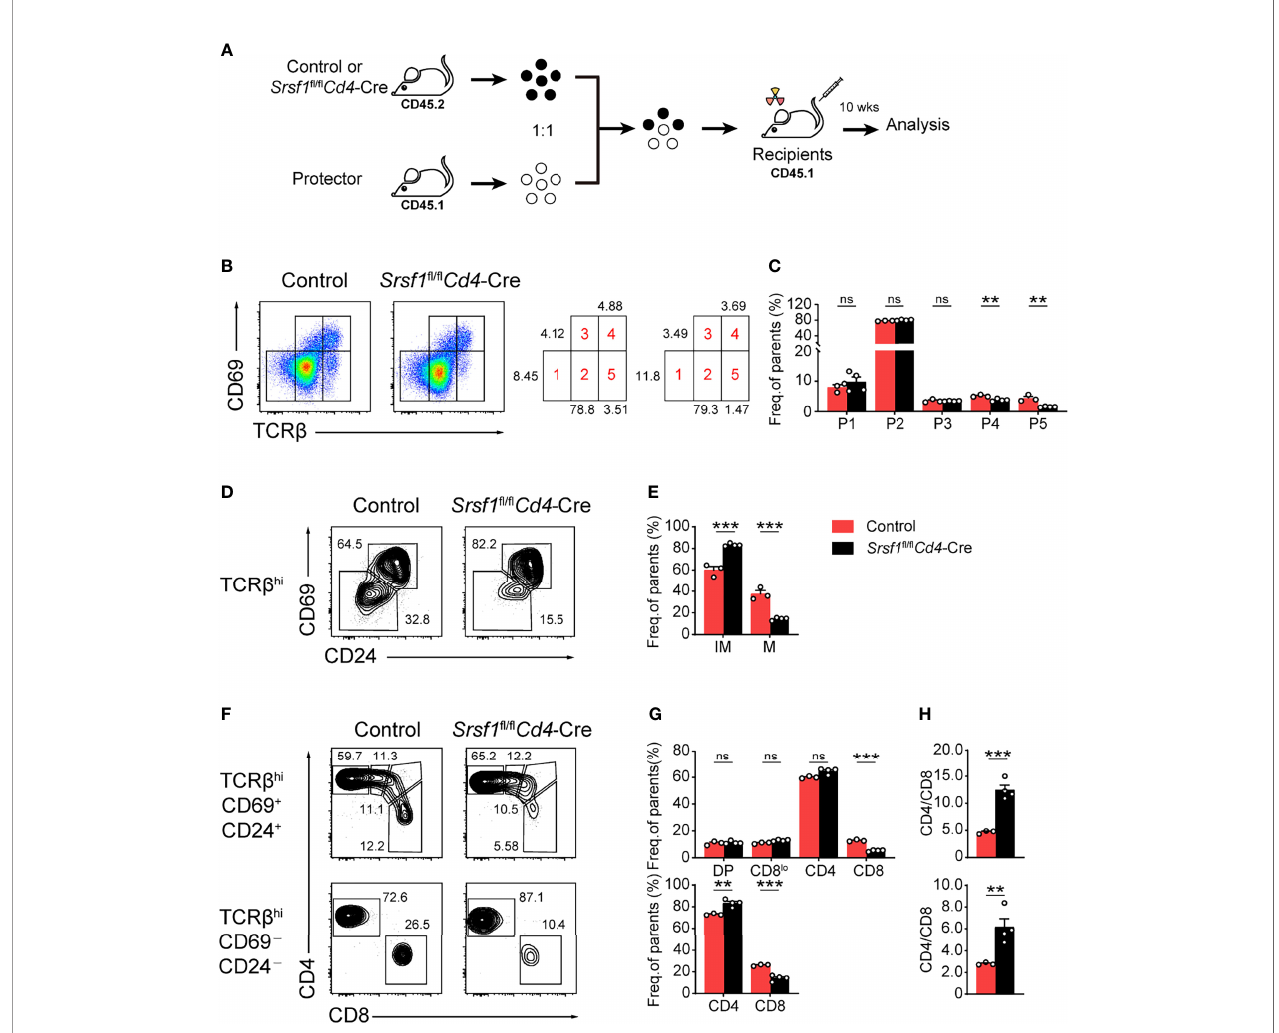
FIGURE 4 | SRSF1 intrinsically regulates the maturation of late thymocytes. (A) The scheme of bone marrow chimeric mice generation. A 1:1 mixture of bone marrow cells from Control or Srsf1 fl / fl Cd4 -Cre mice (CD45.2 + ) together with protector bone marrow cells from B6.SJL wild-type (CD45.1 + ) was transplanted into lethally irradiated B6.SJL recipients (CD45.1 + ). The thymocyte development of recipients was analyzed 10 weeks post transplantation. (B, C) Flow cytometry analysis of the sequentially developmental stages of donor-derived thymocytes. (B) Representative pseudocolor plots show fi ve subsets, including population